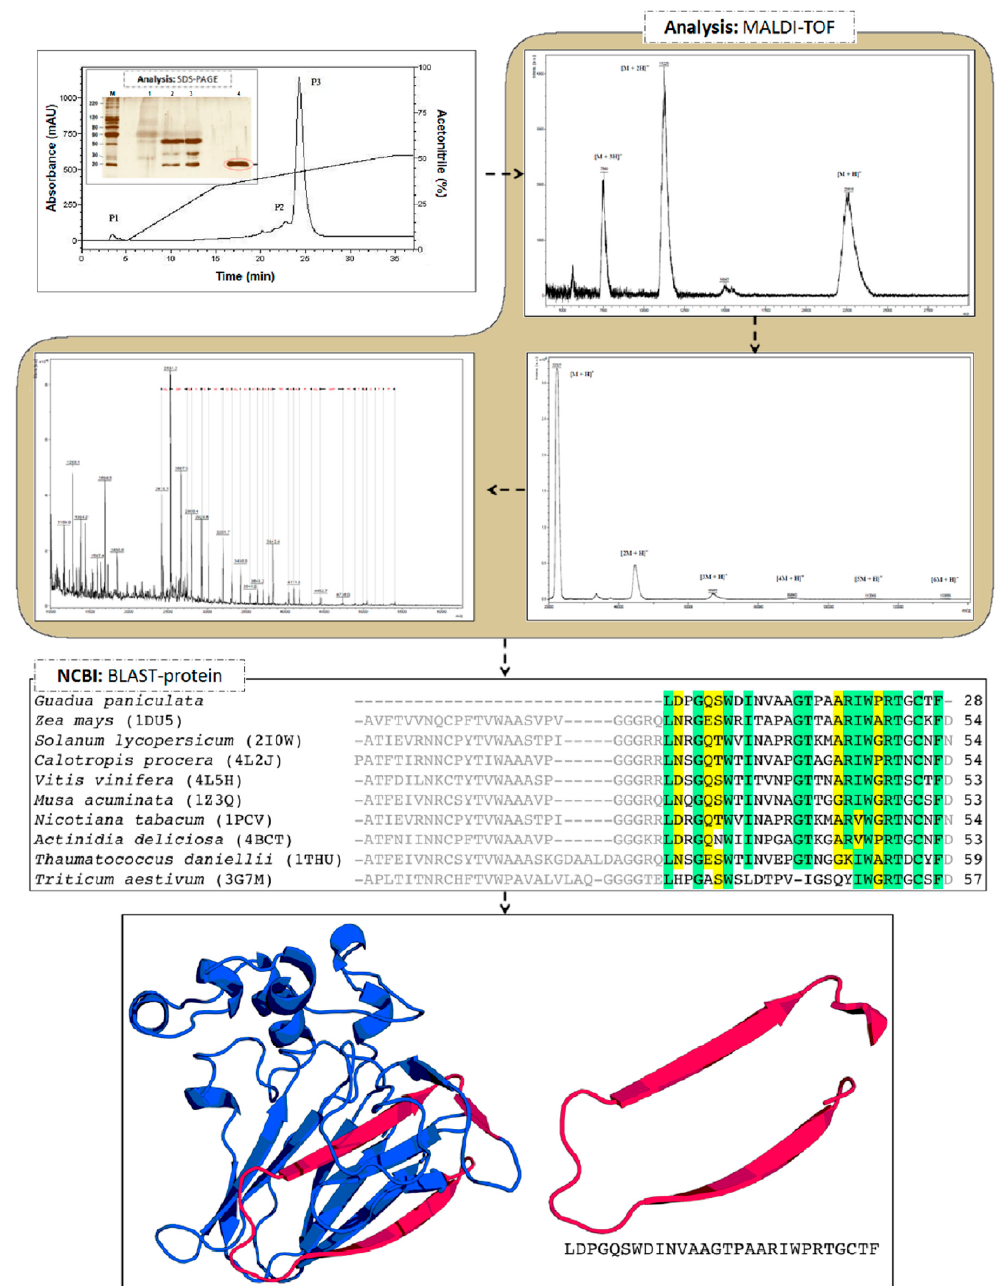
Figure 4. Steps for molecular identification of the bioactive compound isolated from AqGP, and classification as a thaumatin ‐ like protein. Molecular mass profiles resulting from the first three fractionation steps. Where: M: molecular weight marker; 1: AqGP ; 2: fraction 0–30%, precipitation with ammonium sulfate; 3: fraction 0–30%, precipitation with ammonium sulfate, dialyzed; 4: fraction with retention time of 29.9 min, obtained by HPLC C4 semipreparative column. The sequence alignment of the fragment retrieved from mass spectrometry with the PDB (Protein Data Bank) hits (the respective codes are between brackets) is: Zea mays [39] , Solanum lycopersicum [40] , Calotropis procera [41], Vitis vinífera [42] , Musa acuminate [43], Nicotina tabacum [44] , Actinidia deliciosa (Pavkov ‐ Keller et al., unpublished) , Thaumatococcus daniellii [45], and Triticum aestivum [46] . Positions with conserved residues (80%) are highlighted in green; positions with similar residues (80%) are highlighted in yellow. The predicted three ‐ dimensional structure of the chimeric zeamatin harboring the fragment of AqGP . The fragment is highlighted in pink. The structure shows virtually no modification, compared to zeamatin (RMSD = 0.2 Å). The model shows a discrete optimized protein energy (DOPE) score of 0.3; in the Ramachandran plot, 87.4% and 12% of residues are in favored and allowed regions, respectively; with a Z-score on ProSA of −